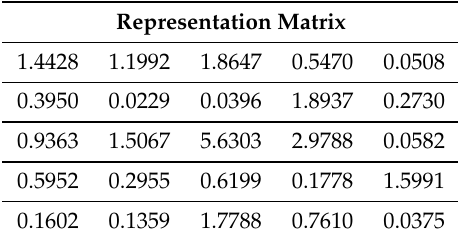
Table 10. Representation matrix to sparsify the